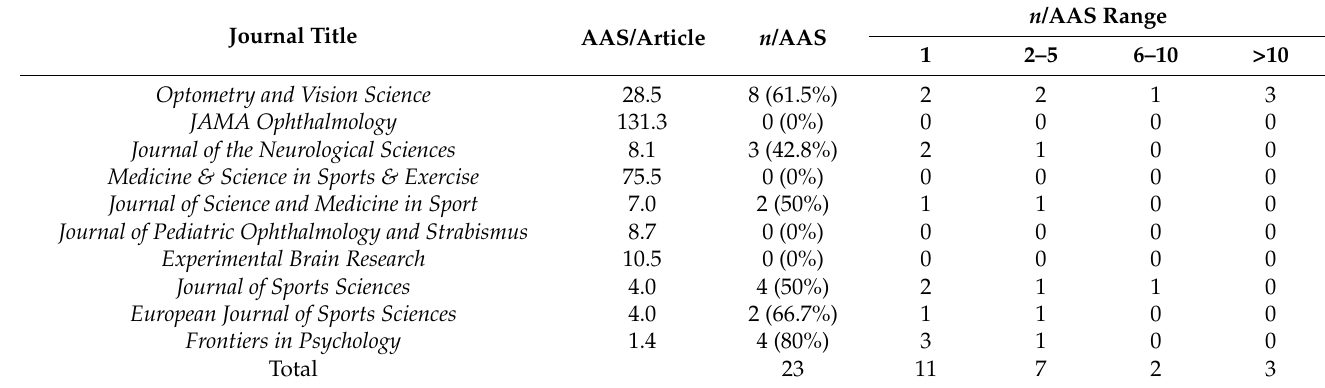
Table 4. AAS rank for each of the journals